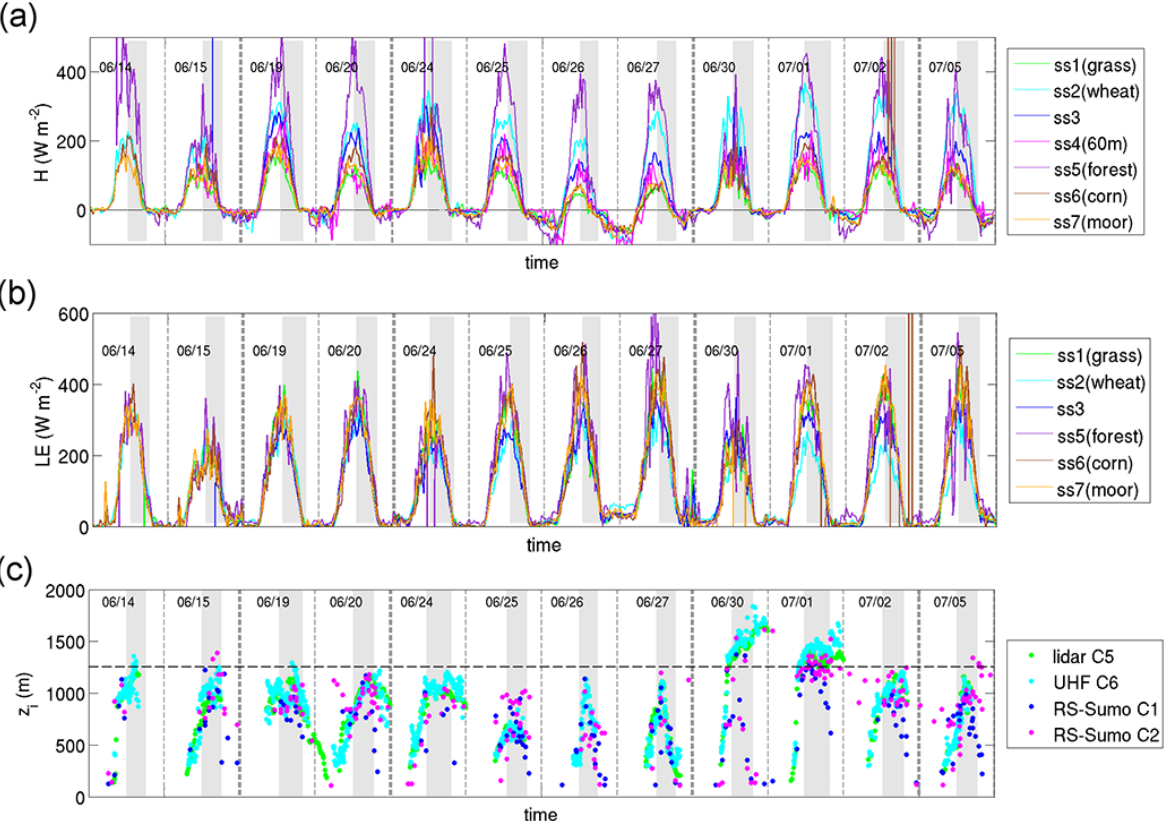
Figure 7. Time series of (a) sensible heat flux H , (b) latent heat flux measured over several surfaces at the different sites (see Fig. 2) and (c) estimates of Z i from various measurements, using criteria (C1) in dark blue, (C2) in pink, (C5) in green and (C6) in bright blue defined in the text. The shaded areas mark the AT period. In (c) , the horizontal dashed line indicates Z i =